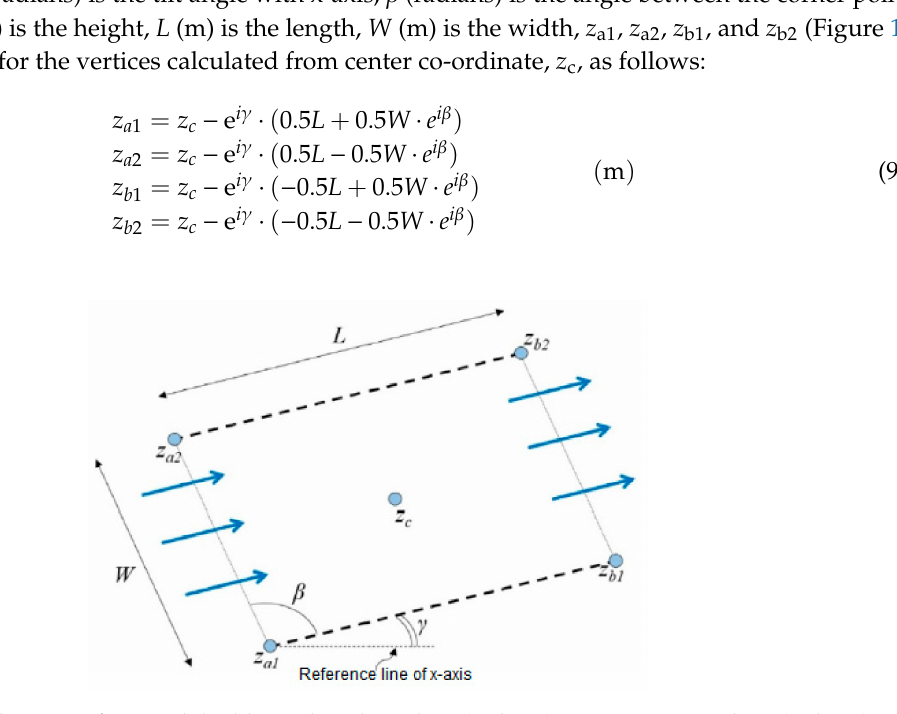
Figure 14. Schematic of an areal doublet with a tilt angle, γ (radians), corner point angle, β (radians) located at center z c , width, W (m), and length, L